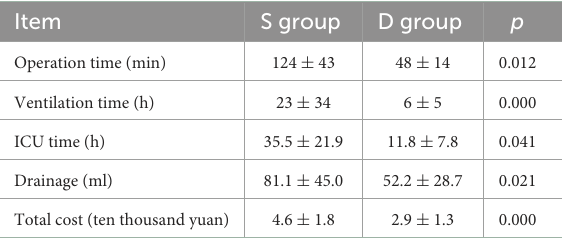
TABLE 3 Comparison of postoperative serum lactate between surgery repair group (S group) and transthoracic device closure group (D group) after